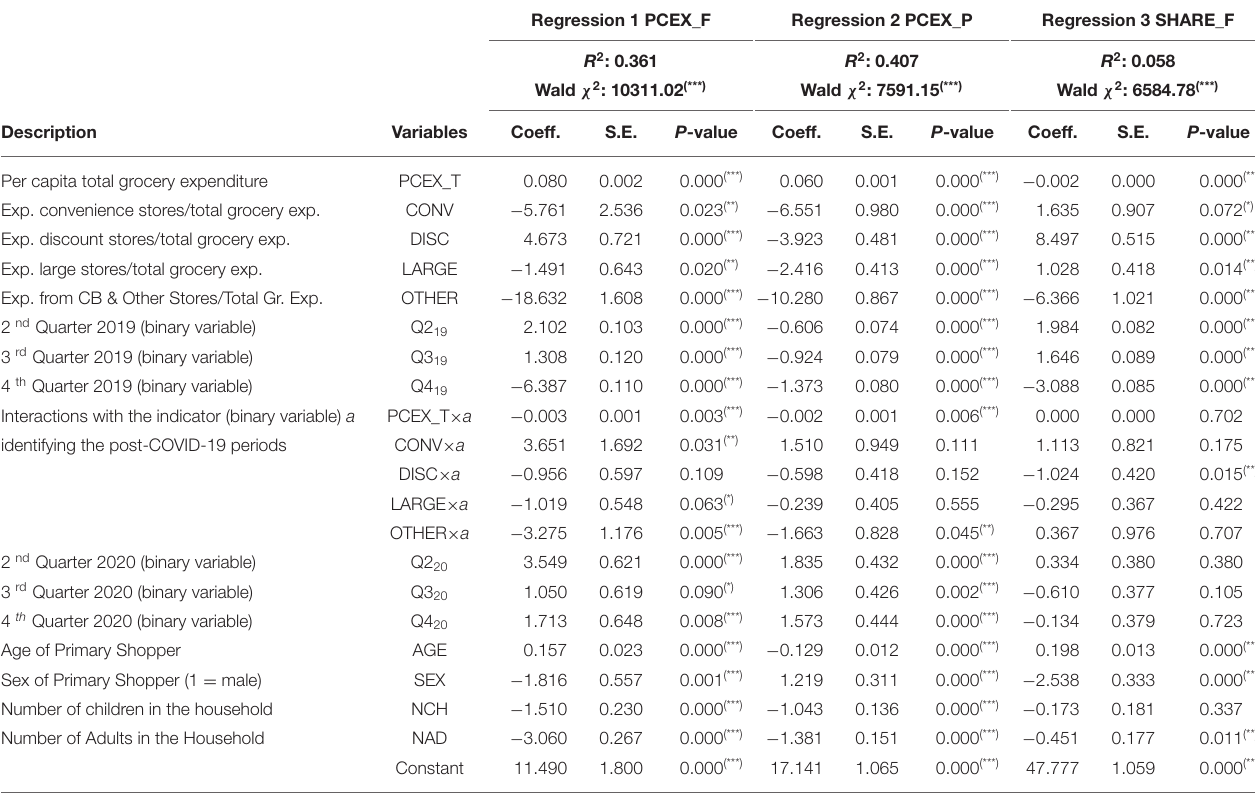
TABLE 5 | Results of the regressions of per capita expenditure for fresh fruit and vegetables (PCEX_F), per capita expenditure for processed fruit and vegetables (PCEX_P) and share of expenditure for fresh fruit and vegetables on total expenditure for fruit and vegetables